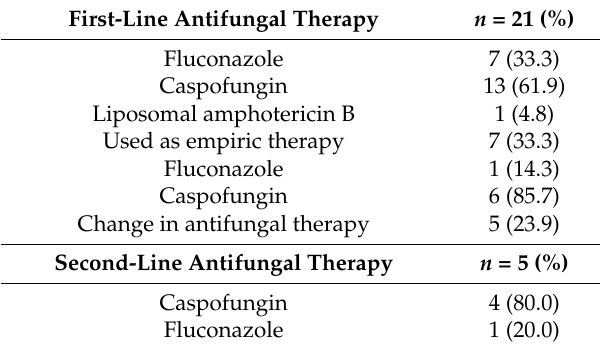
Table 4. First- and second-line antifungal therapy ( n = 21).